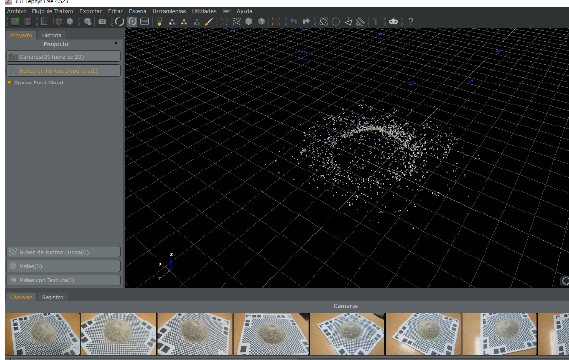
Figure 2. Interface of 3DF Zephyr Free showing one of the steps of the process (sparse point cloud generation).